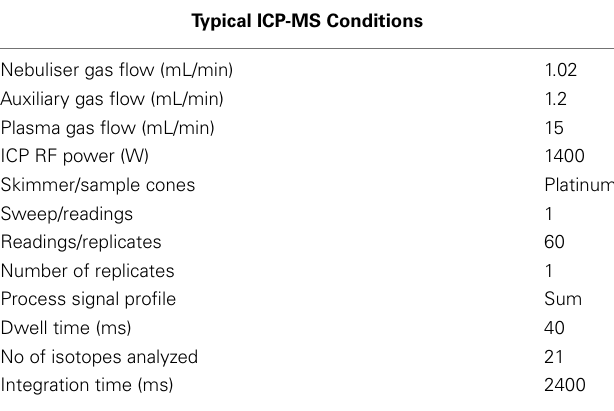
Table 1 | FI–SPE–ICP-MS conditions for determination of trace metals in seawater (O’Sullivan et al., in preparation).